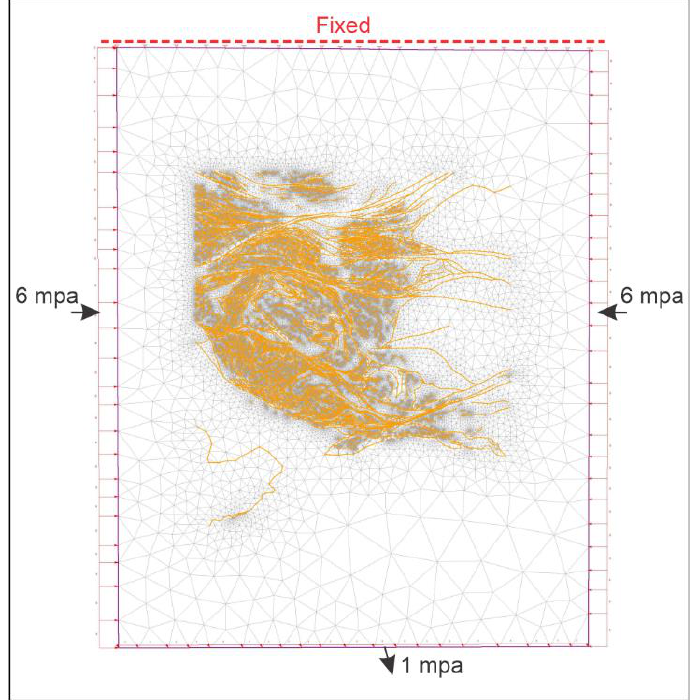
Figure 7. Schematic FEA framework of loading conditions for the simulated stress regime.